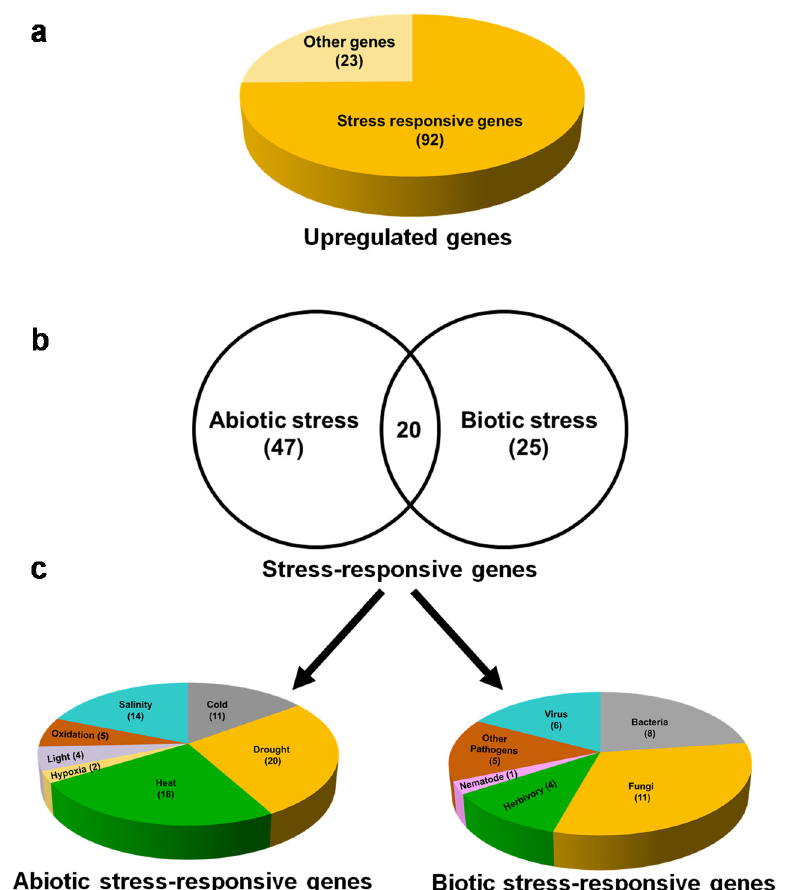
Figure 5. Exogenous β CC treatment mainly upregulates stress-responsive genes. Among the 115 upregulated genes, ( a ) 92 genes are involved in stress response, and only 23 genes are performing other functions. Among these 92 upregulated stress-responsive genes, ( b ) 47 and 25 genes are specific to abiotic and biotic stress, respectively. There are 20 genes that are commonly involved in both abiotic and biotic stress responses. ( c ) Abiotic stress-responsive genes are related to drought, heat, salinity, hypoxia, oxidative stress, light, and cold (left panel); on the other hand, biotic stress-responsive genes are related to herbivory, fungi, bacteria, nematode, viruses, and other pathogens (right panel). A few genes that are involved in multiple stresses are counted under each of those respective stresses; therefore, the total numbers of abiotic and biotic stress-responsive genes are more than 47 and 25, respectively.